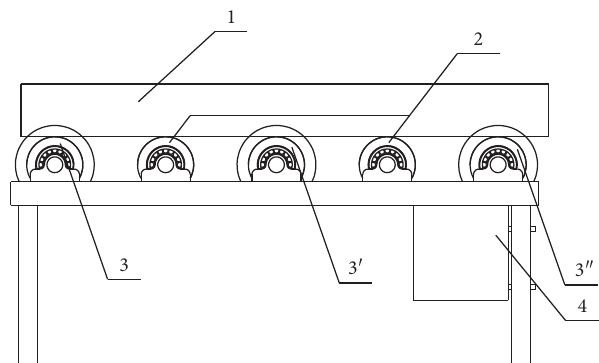
Figure 9: Structure diagram of the cathodic protection conveyance roller with a conductive roller. 1, magnesium plate; 2, alumina ceramic conveyor roller set; 3, 3, . .. , 3 n , first, second, .. . , the nth conductive roller; 4, adjustable power box.